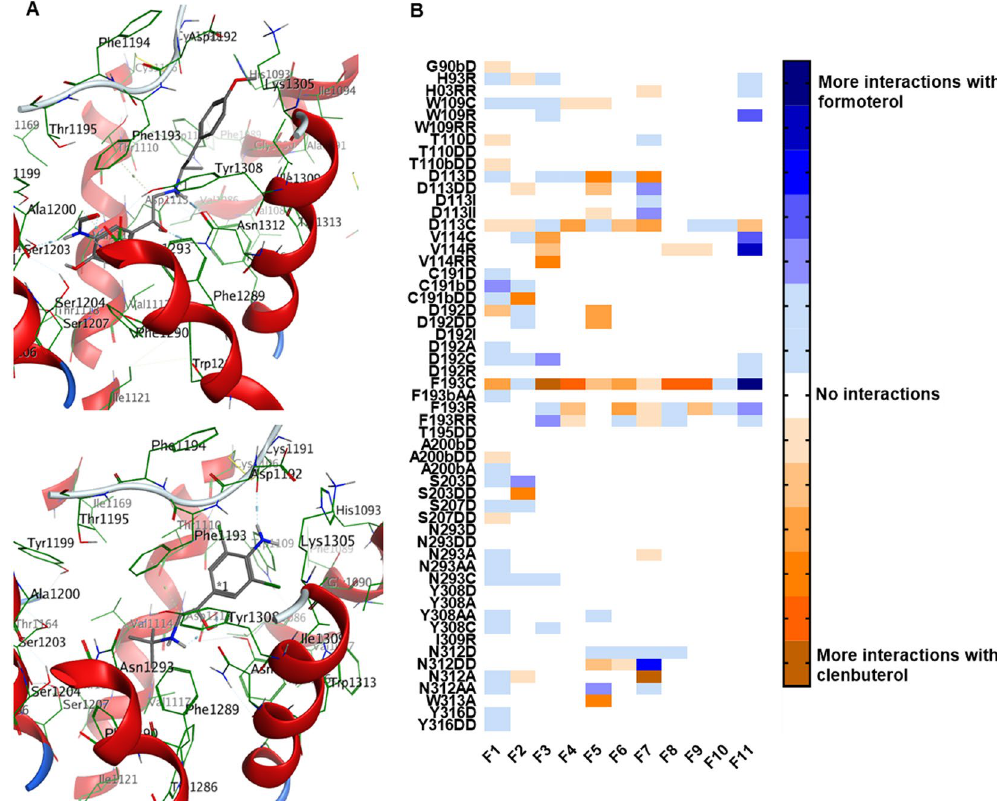
Figure 5. Formoterol and clenbuterol have distinct interaction fingerprints with the β 2 AR. ( A ) Representative poses of formoterol and clenbuterol in the 4LDO crystal structure. Formoterol’s methoxyphenyl group (top) allows it to extend further across the binding pocket than clenbuterol (bottom), allowing formoterol to simultaneously interact with TM3, TM5, and ECL2 and be in closer proximity to TM2. ( B ) Formoterol and clenbuterol were docked to inactive structures (3NYA, 3NY8, 5D5B) and active structures (4LDE, 4LDL, 4LDO) of the β 2 AR. From the top 30 poses, ligand interactions were matched with structural features F1-F11 and added for each crystal structure. More negative (orange) values correspond to a greater number of interactions with clenbuterol, while more positive (blue) values correspond to a greater number of interactions with formoterol. Interactions are displayed as Residue-interaction type (D- hydrogen bond donor, DD- strong hydrogen bond donor, I- ionic, II- strong ionic, A- hydrogen bond acceptor, AA- strong hydrogen bond acceptor, C- contact, R- arene, RR- strong arene). Residues followed by a b (e.g., G90b) indicate an interaction with the peptide backbone of the corresponding